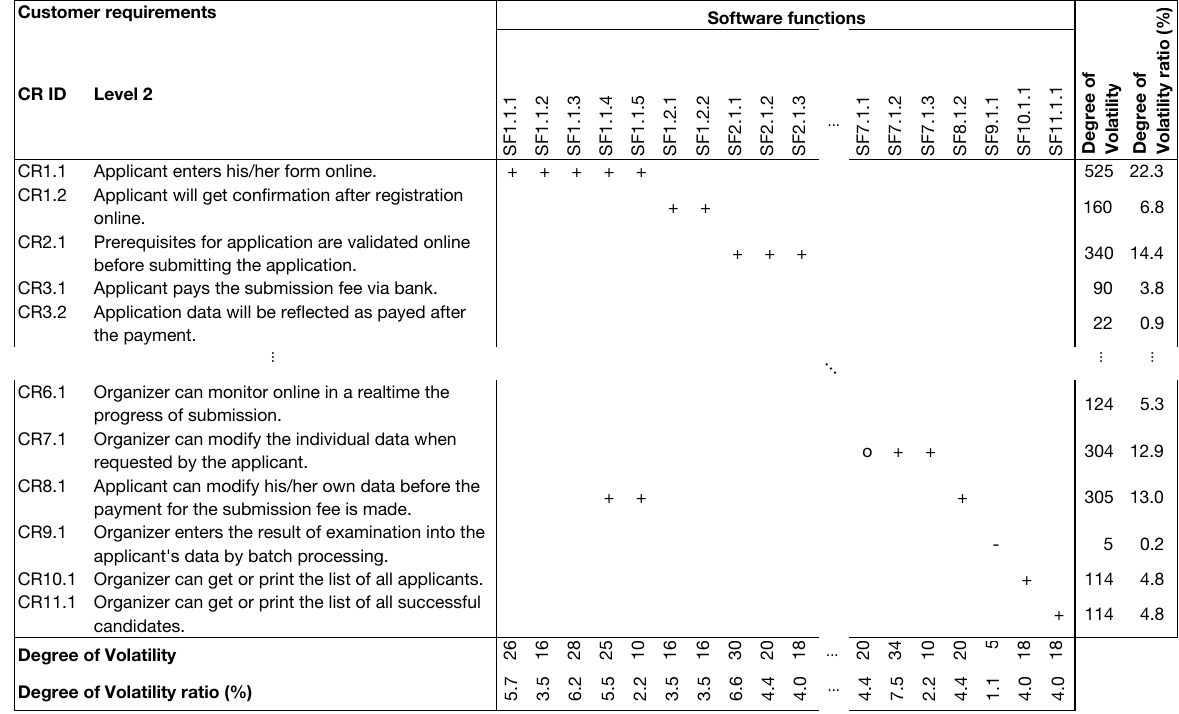
Table 7. Calculation of the degree of volatility of the customer requirements from the degree of volatility of the software functions